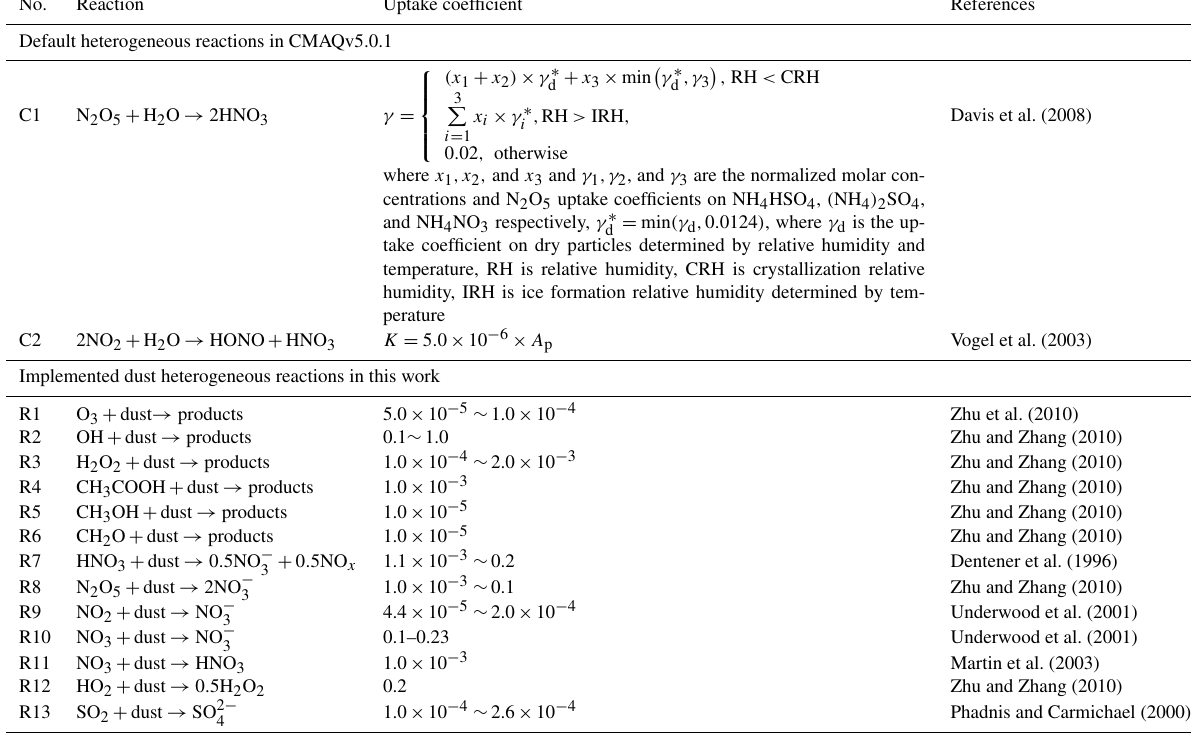
Table 3. Heterogeneous reactions and uptake coefficients. No. Reaction Uptake coefficient Default heterogeneous reactions in CMAQv5.0.1